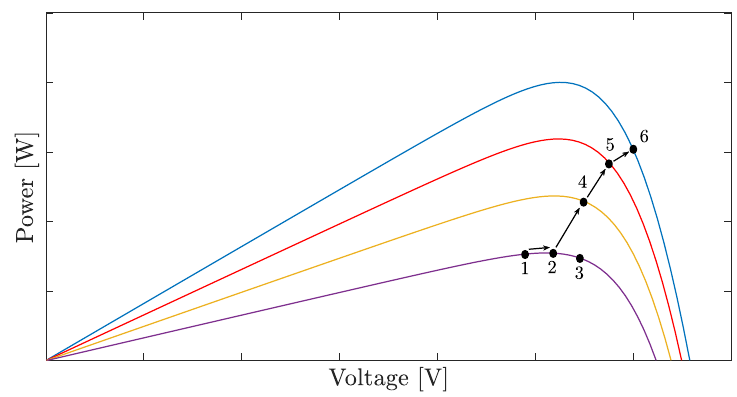
Figure 7. Drift occurrence with the conventional P&O method for fast change of